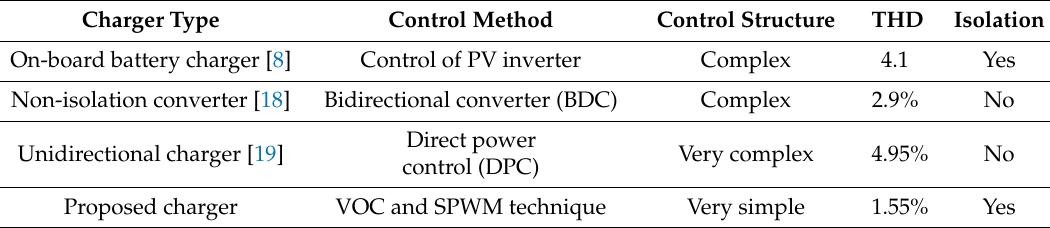
Table 1. The performance of the proposed charger compared with existing chargers.